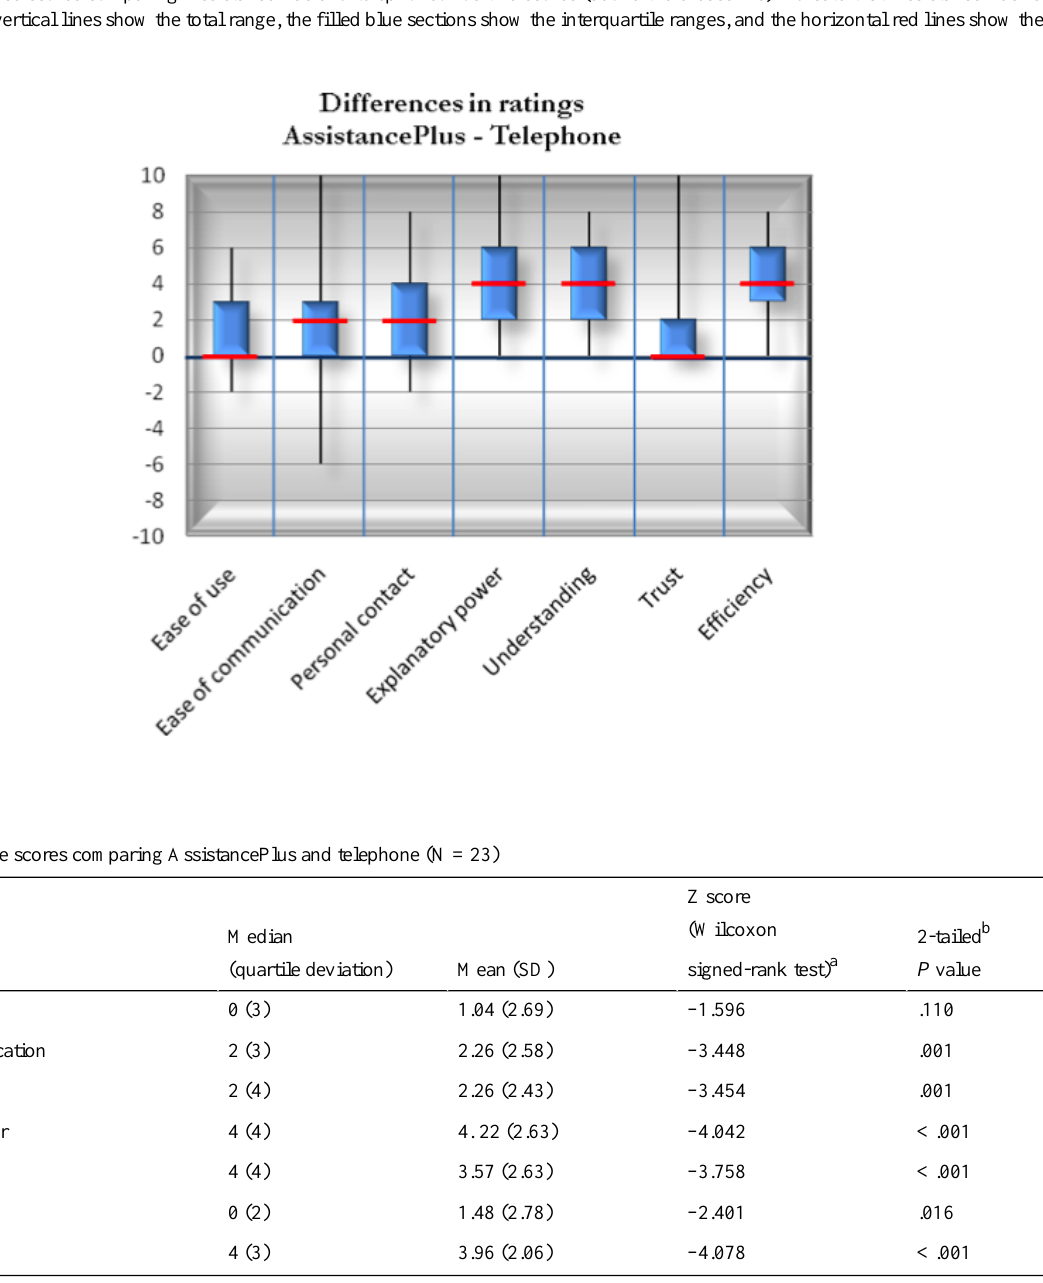
Figure 4. Preference scores comparing AssistancePlus and telephone. Positive scores (above the 0 baseline) indicate that AssistancePlus received a